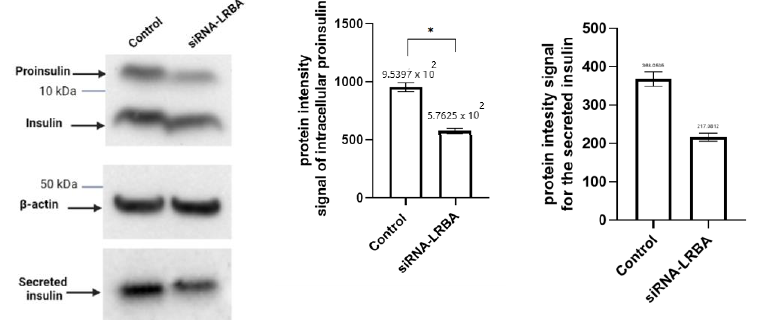
Figure 4. siRNA-mediated knockdown of LRBA. MIN6 cells were transfected for 72 h with siRNA targeting LRBA. ( A ) The Western blot shows successful knockdown of LRBA (at ≈ 319 kDa). Β -actin was us ed as a loading control (at ≈ 43 kDa). ( B ) qRT-PCR quantification of LRBA mRNA in MIN6 cells after 72 h of transfection yielded a knockdown efficiency of ≈60%, respectively. Error bars rep- resent SEM of three independent experiments.